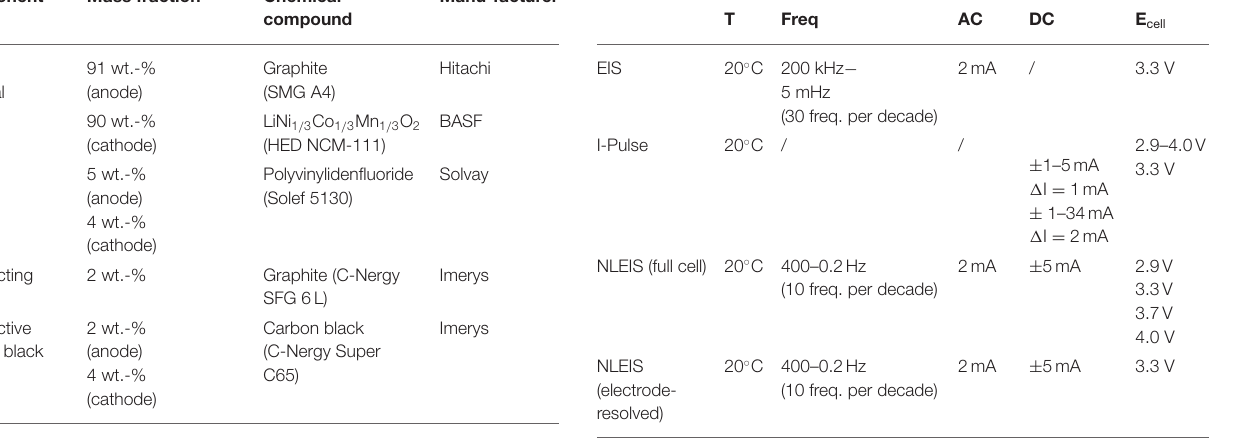
TABLE 3 | Experimental parameters for EIS spectra, I-Pulse measurements, and NLEIS spectra as a function of state of